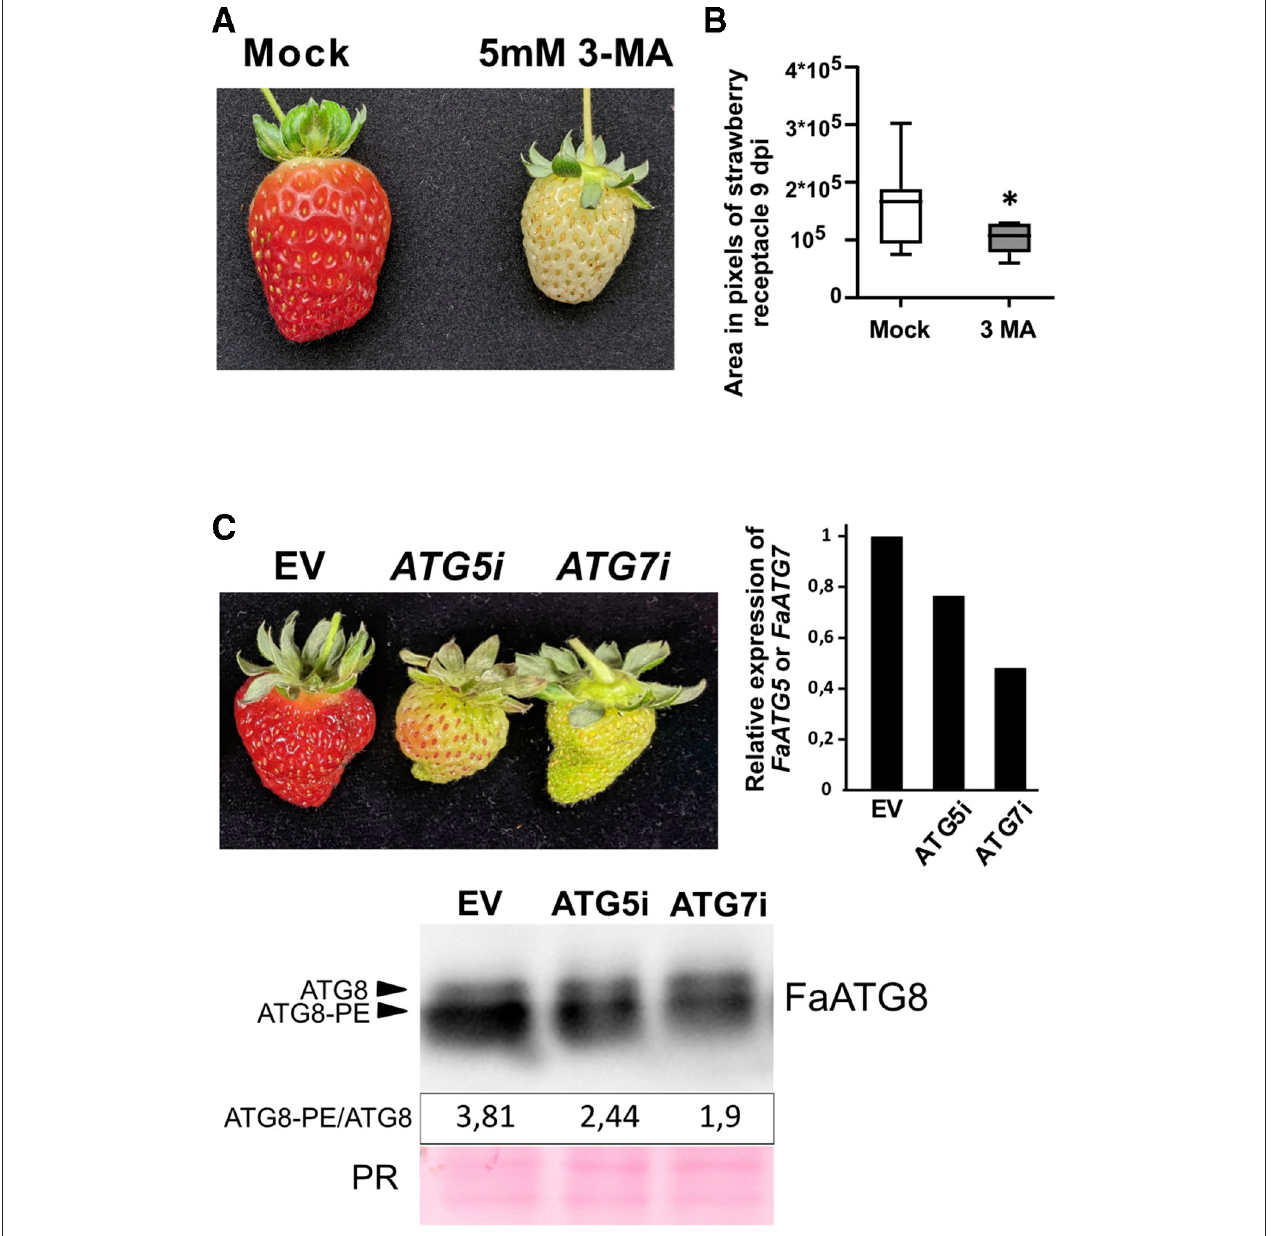
FIGURE 6 | Effect of autophagy blocking over strawberry ripening. (A) Representative image showing the effect over ripening of 3-MA in F x ananassa cv “San Andreas”. (B) Fruit area in 3-MA treated fruits compared to mock treated samples. Variance difference between mock treated lines and 3-MA treated lines were analyzed using an F-test and * denote significantly different with a P < 0,005. (C) Up-left, representative image showing the effect over ripening of FaATG5 or FaATG7 silencing. Up-right, qRT-PCR analysis of ATG5 or ATG7 expression in infiltrated receptacles. Down, immunoblot analysis of ATG8 levels in control and silenced fruits and quantification of ratio between lipidated (ATG8-PE) and non-lipidated form (ATG8). The (C) panel is representative of three independent experiments. EV, Empty vector; PR, Ponceau Red.